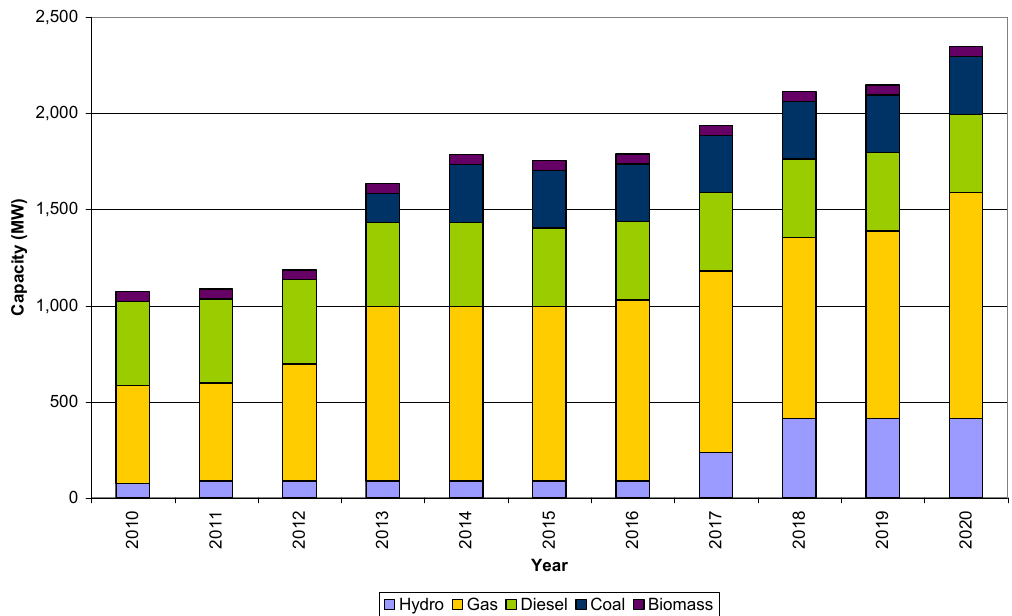
Figure 3. SESB plant-up